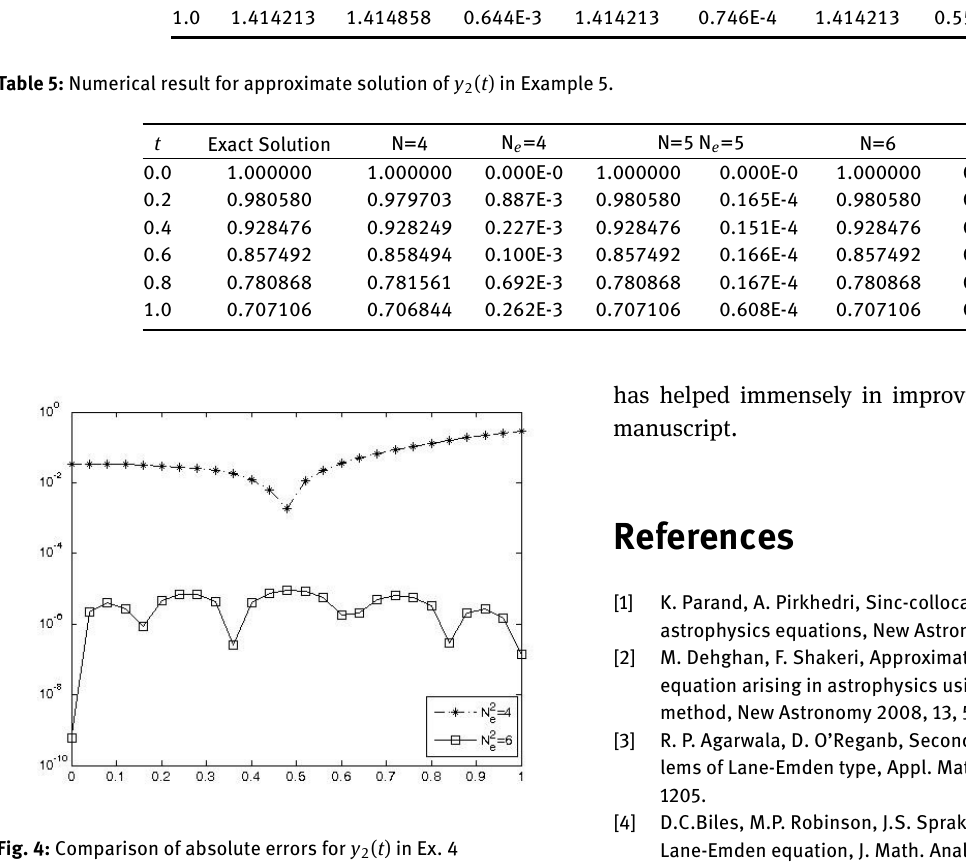
Fig. 4: Comparison of absolute errors for y 2 ( t ) in Ex.